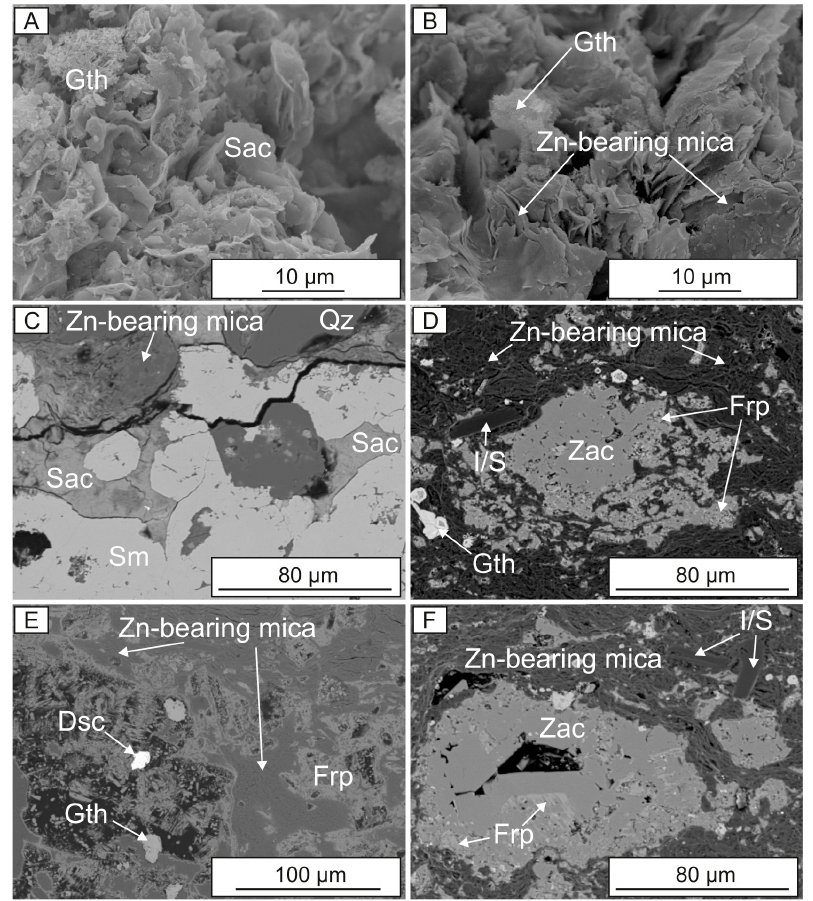
Figure 6. Secondary and backscattered electron (BSE) images of clay minerals from Cristal ( A – C ) and Mina Grande ( D – F ) deposits; ( A , B ) 3D images of sauconite (Sac) and interstratified I/S showing “cornflake” (sauconite) and “flat-lying flake” (Zn-bearing illite or I/S) textures. The latter are commonly obliterated by thin crusts of micrometric goethite (Gth) concretions; ( C ) Sauconite surrounding Zn-bearing mica and filling fractures in smithsonite (Sm) (sample CR03-3); ( D – F ) Zaccagnaite (Zac) replacing fraipontite (Frp), and occuring in cavities of Zn-bearing I/S. Goethite (Gth) and descloizite (Dsc) are commonly found in this mineral assemblage (sample ZB-1).